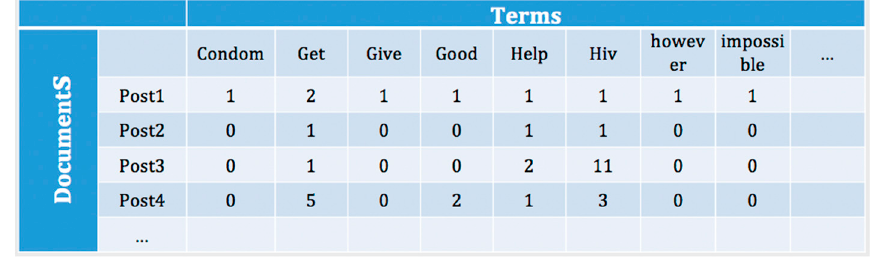
Figure 2. Representation of DocumentTermMatrix.